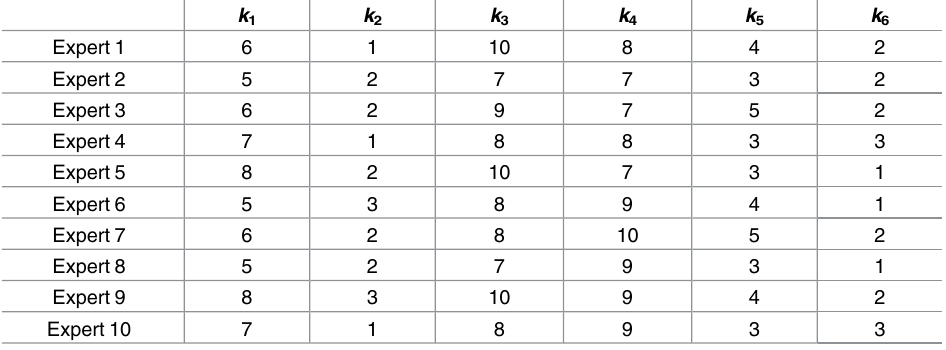
Table 3. Results of experts’ judgments regarding the importance of hazard assessment